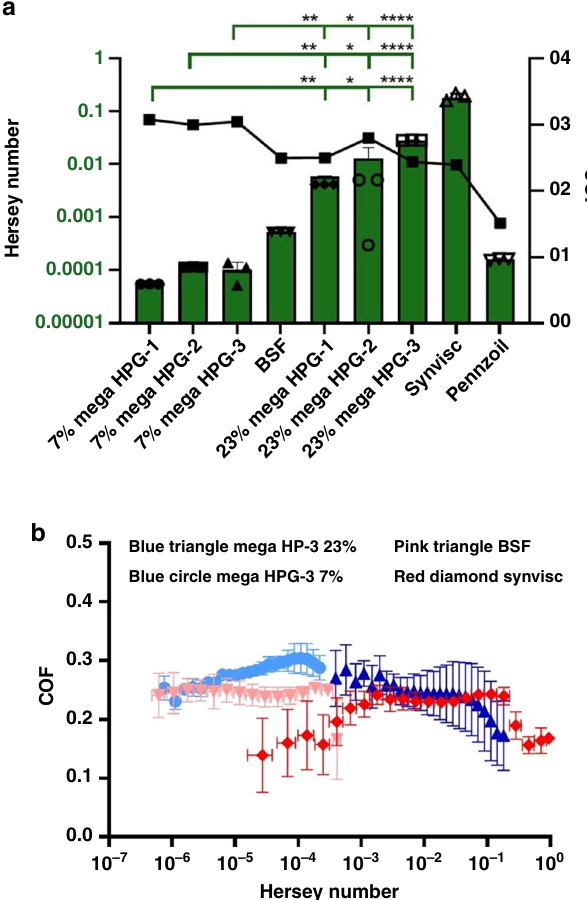
Fig. 3 Lubrication characteristics of mega HPGs. a Graph of the Hersey number at which each group transitions from boundary mode to mixed mode lubrication (left y -axis and green bars). The COF at the time each lubricant transitions from boundary to mixed mode lubrication (right y -axis, black symbols). Error bars represent standard deviation, N = 3 replicates; one-way ANOVA used to compare groups, statistical differences indicated by asterisk, where * p < 0.05, ** p < 0.01, **** p < 0.0001. For full list of statistical results see Supplementary Information. b . Stribeck curves for best preforming mega HPG (mega HPG-3) at both 7 and 23 w/v%, as well as two controls, BSF and Synvisc One. Error bars represent standard deviation, N = 3 replicates.